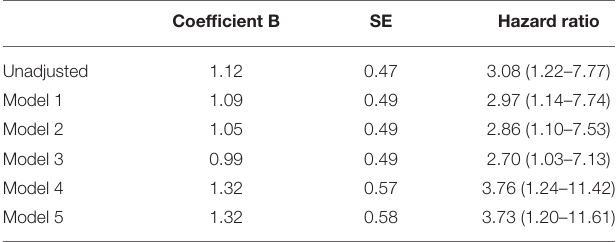
TABLE 3 | Association between high plasma concentration of Apo CIII ( ≥ 10.3 mg/dL), and ischemic stroke/TIA events by different Cox Regression models (subjects with low plasma concentration of Apo CIII, < 10.3 mg/dL, are considered as reference group).